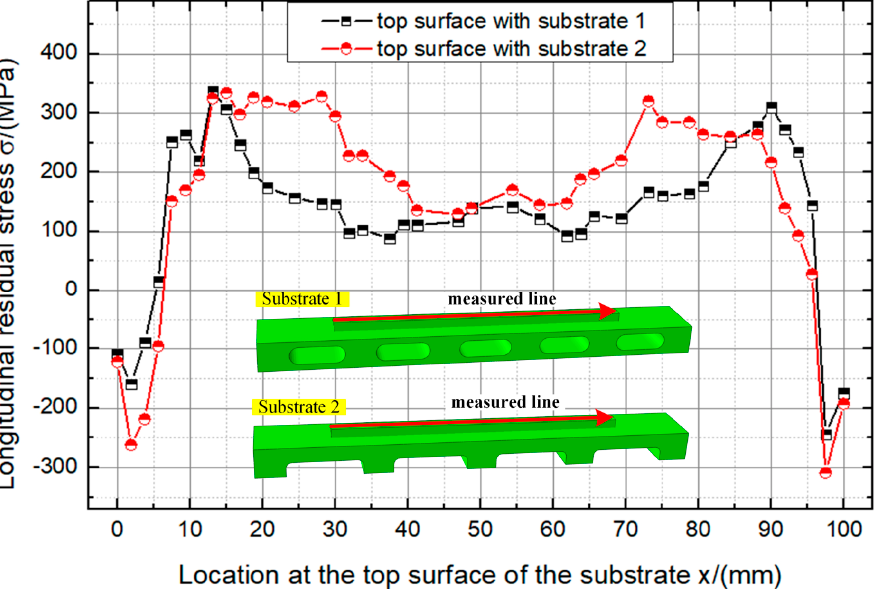
Figure 10. Longitudinal residual stresses on the top surfaces of the deposition layers with different substrate structures.